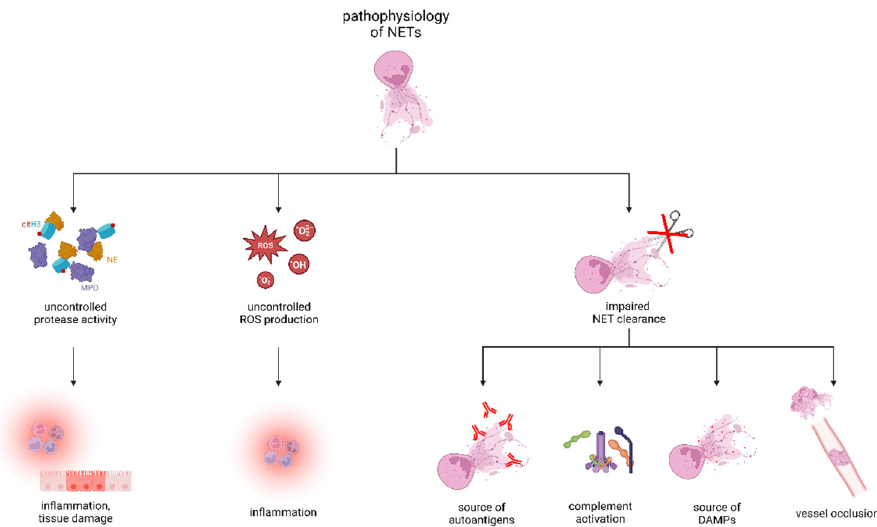
Figure 2. Pathophysiology of NETs in diseases. Abnormal or impaired clearance of NETs can cause several neutrophil-driven disorders. Enhanced uncontrolled release of NET-associated proteases and ROS promotes inflammation and can lead to tissue damage. Impaired NET clearance and, thus, the persistent presence of NET chromatin and associated proteins in the extracellular space serve as a source of autoantigens and DAMPs, activate the complement, and, in the case of aggregation, occlude vessels. Created with BioRender.com.